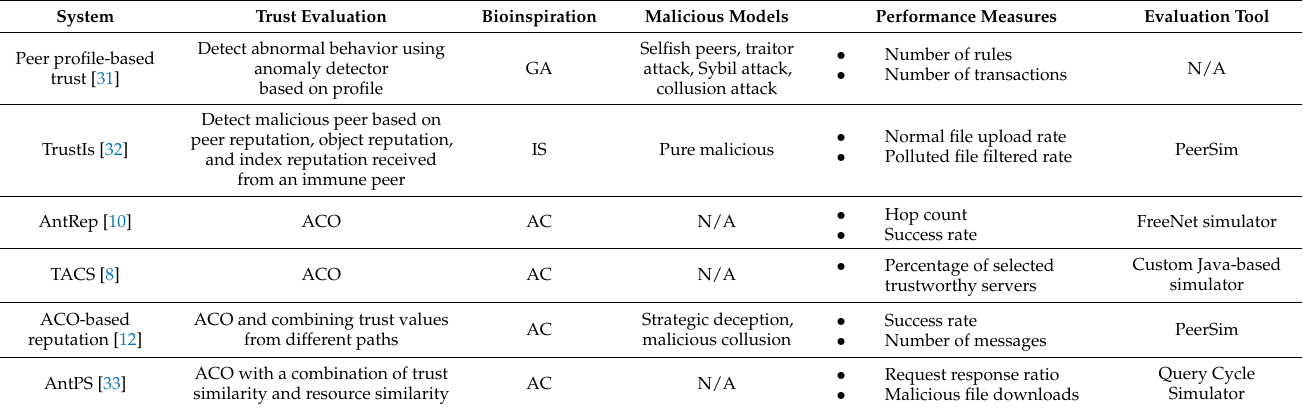
Table 1. Comparison between reviewed bioinspired trust